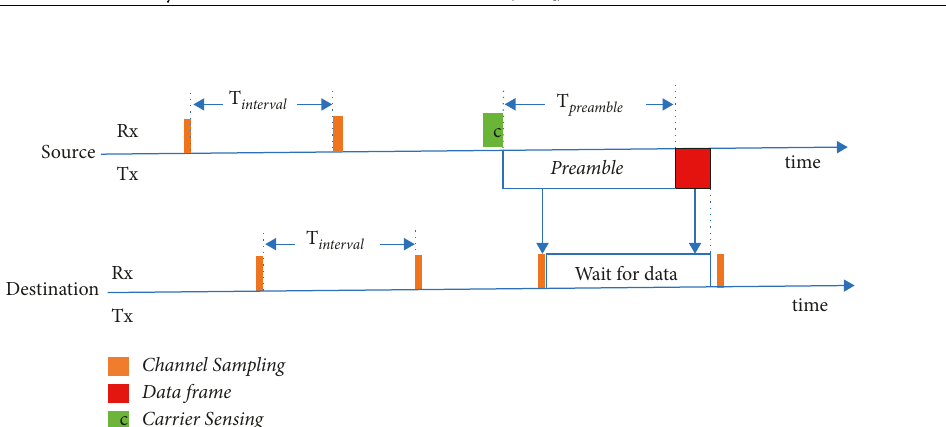
Figure 7: The operation of asynchronous duty cycle [154].